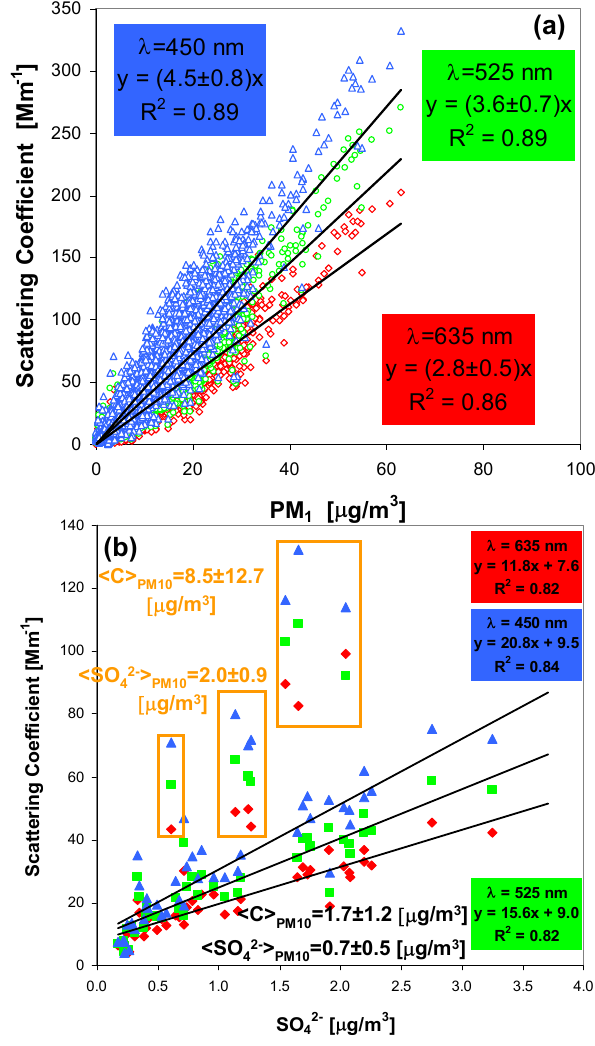
Fig. 6. Correlation between the aerosol scattering coefficients at 450, 525, 635nm and PM1 (a) and fine sulfate concentrations (b)